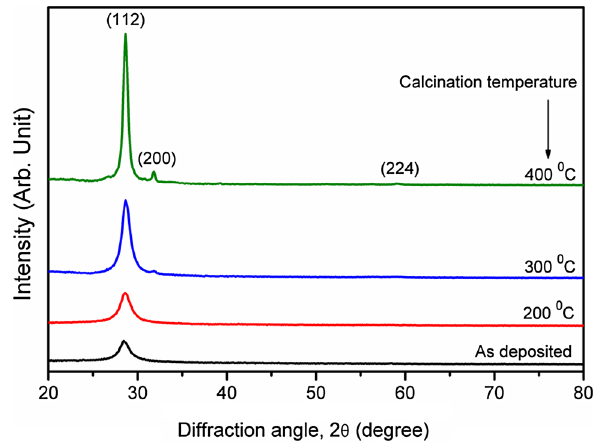
Fig. 1 XRD pattern of as-deposited and after calcination CZTS thin films at different temperatures for kesterite-CZTS crystal